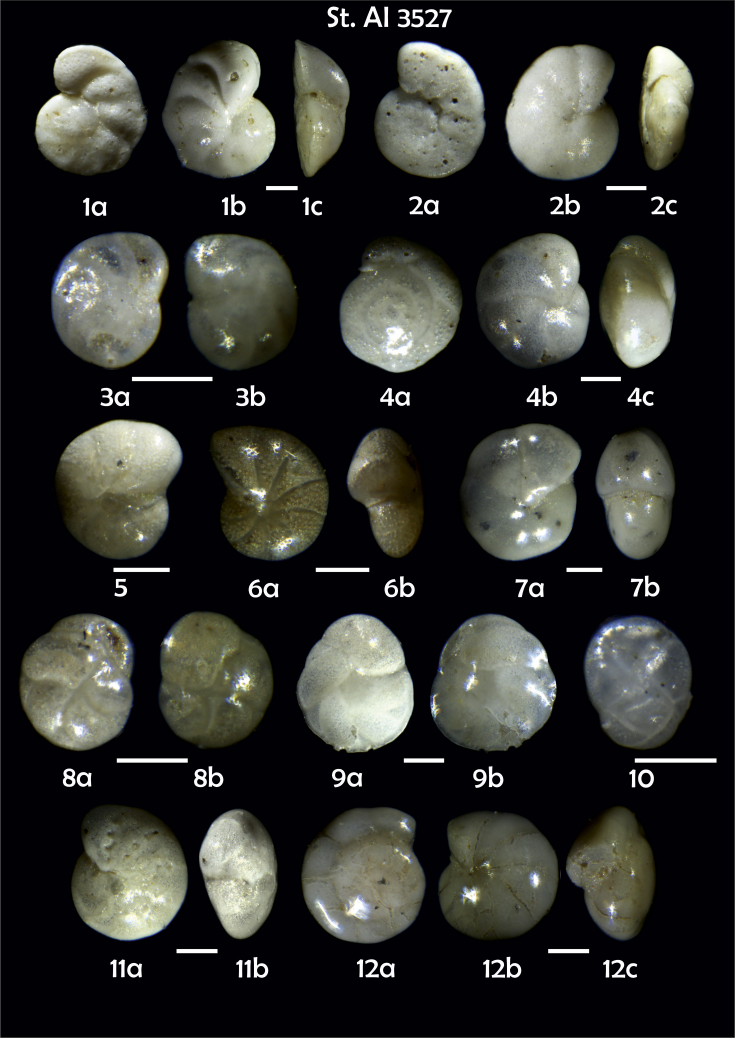
Station 35271Cibicidoides sp. cf. C. lobatulus, a umbilical view, b spiral view, c apertural view. 2C. lobatulus, a umbilical view, b spiral view, c apertural view. 3C. wuellerstorfi, a umbilical view, b spiral view. 4C. bradyi, a umbilical view, b spiral view, c apertural view. 5Melonis sp. 6Melonis barleeanus,a side view, b apertural view. 7Pullenia bulloides, a side view, b apertural view. 8Cassidulina reniforme, a apertural view, b lateral view. 9C. teretis, a lateral view, b apertural view. 10Globocassidulina subglobosa. 11Elphidium excavatum, a lateral view, b apertural view. 12Gyroidina orbicularis, a spiral view, b umbilical view, c apertural view. 13Alabaminella weddellensis, a spiral view, b umbilical view. 14Fissurina squamosoalata. 15Bolivina earlandi.16Bulimina mexicana. 17Trifarina angulosa. 18T. fluens.19Uvigerina sp. 20Uvigerina sp. cf. U. mediterranea.21Cyclammina pussila, a lataral view, b apertural view. 22Saccamimina sphaerica. 23Lagenammina difflugiformis. 24 ?. 25Sigmoilopsis schlumbergeri. Scale 100 μm.